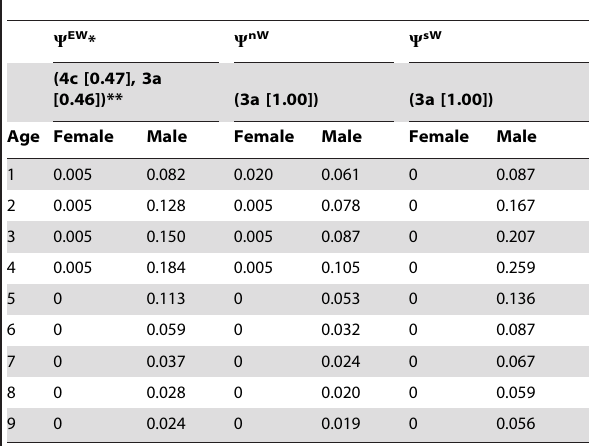
Table 3. Estimated annual age- and sex-specific occupancy probabilities for eastern DPS Steller sea lions being in their non-natal DPS during the breeding season; the estimates were derived from the best of 9 models for each set of estimates (see Table 2).